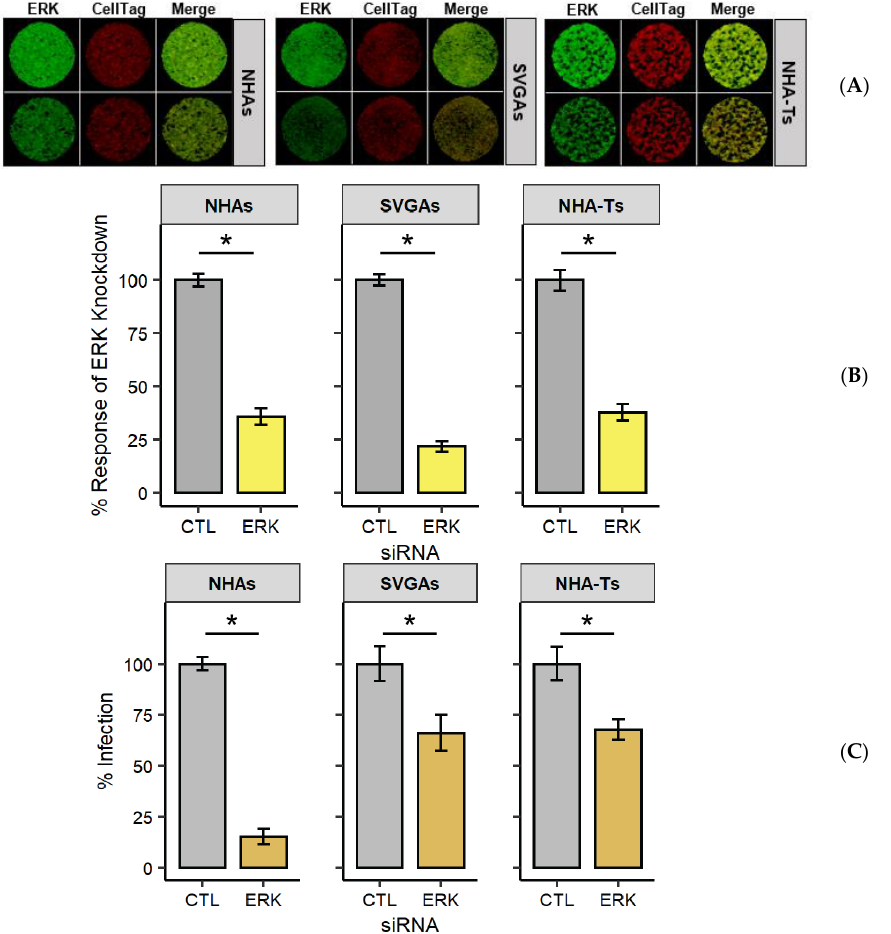
Figure 3. ERK knockdown significantly reduced JCPyV infection in NHAs. NHAs, SVGAs, and NHA-Ts were transfected with ERK1/2 or EGFR (CTL) siRNA. At 72 h post-transfection, cells were fixed for analysis of ERK protein expression ( A , B ) or infected ( C ). ( A ) ERK1/2 protein expression was determined by in-cell western (ICW), staining for Total ERK1/2 (green) or CellTag (red). ( B ) Percentage of protein knockdown was measured by ICW signal intensity values per [(ERK1/2)/Cell Tag × 100% = % response] within each ICW analysis using LI-COR software. Error bars indicate SD. Student’s t -test was used to determine statistical significance comparing EGFR (CTL) siRNA-treated cells to ERK1/2 siRNA-treated cells, for each cell type. *, p < 0.01. ( C ) Following 3 days post-transfection, cells were infected with JCPyV (MOI = 1.0 FFU/cell) at 37 ◦ C